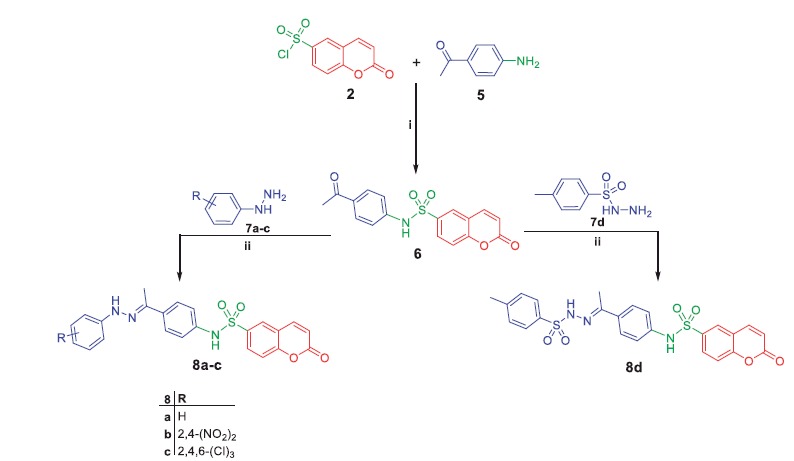
Synthesis of target compounds 8a–d; Reagents and conditions: (i) Pyridine/stirring, rt 24h; (ii) EtOH/AcOH (catalytic)/reflux 8 h.